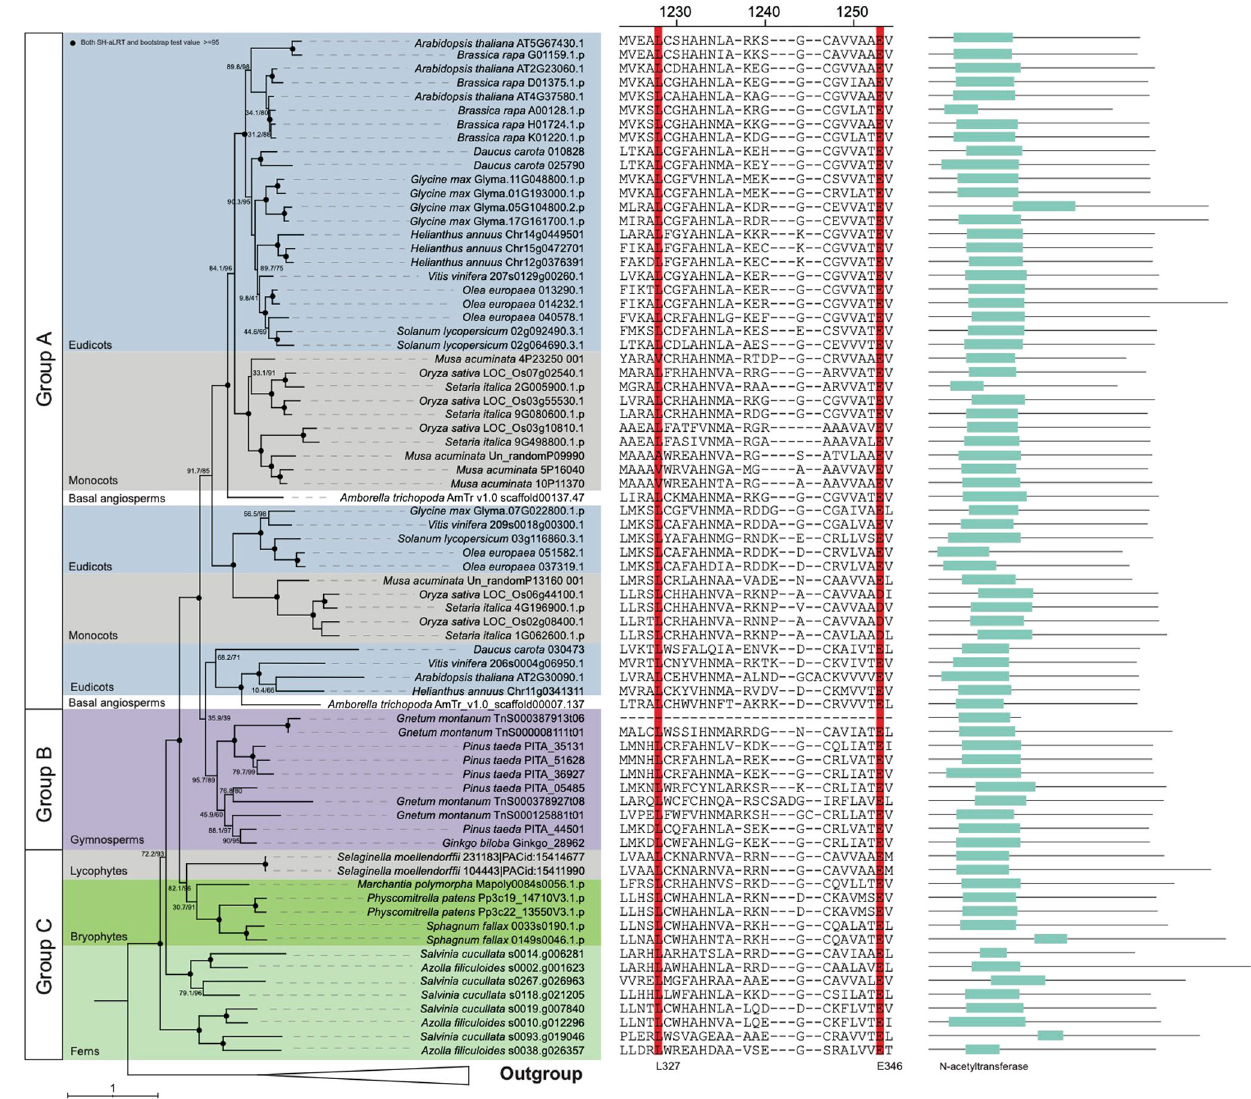
Fig. 1 Phylogenetic tree and structural comparisons of plant HLS1 orthologs. Nodal support values are estimated by SH-aLRT test (SH) and ultrafast bootstrap (UFBS) in IQ-TREE2. The “ N-acetyltransferase ” domain locations were mapped near each branch. The two conserved amino acids in AtHLS1 (L327 and E346) were highlighted in